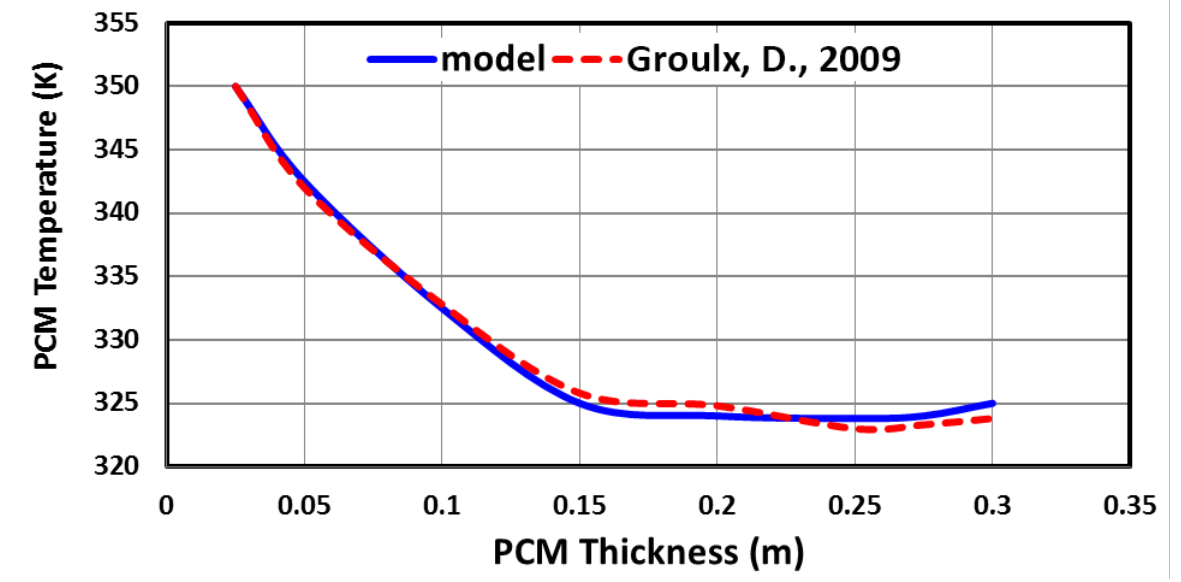
Figure 4. Validation of the mathematical model [14].